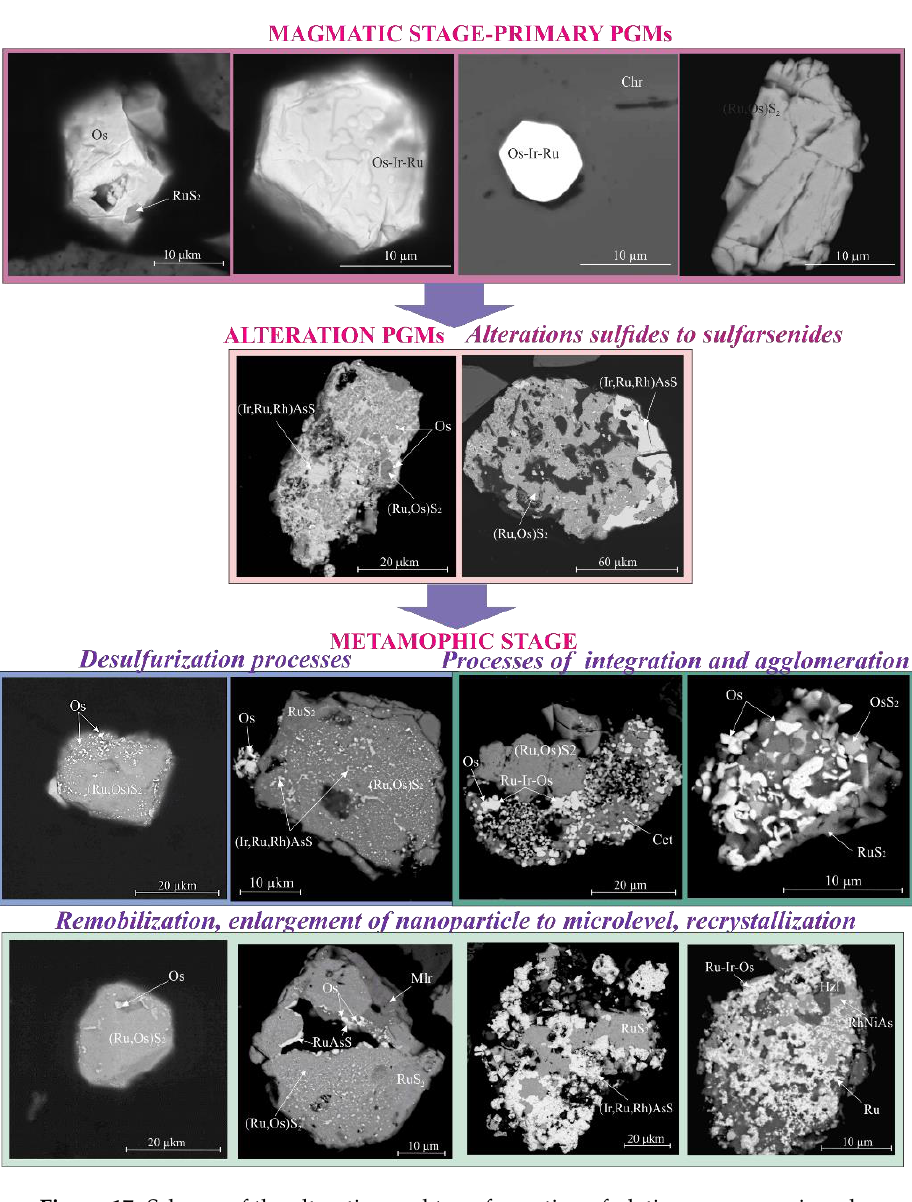
Figure 17. Scheme of the alteration and transformation of platinum-group minerals. III—Stage of Ophiolite Obduction. Regional Metamorphism.